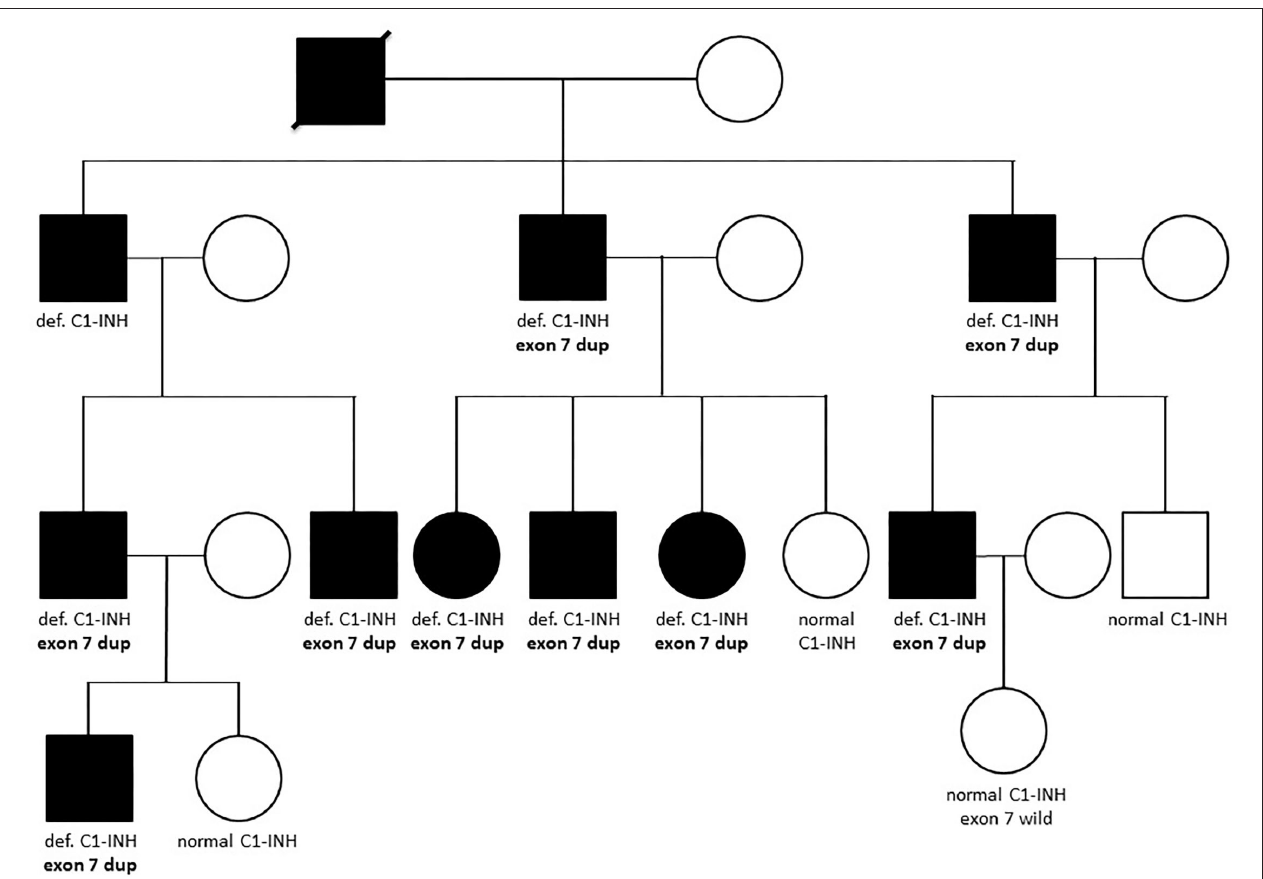
FIGURE 2 | Family tree of a patient with the novel SERPING1 exon 7 duplication. Affected members of the family are depicted with dark symbols, while all available results of complement and genetic measurements are denoted below the symbols. Def. or normal C1-INH means deficient or normal activity and level of C1-inhibitor, respectively. “Exon 7 dup” refers to the heterozygous carrier state of the duplication of SERPING1 exon 7, while individuals denoted as “exon 7 wild” does not carry this